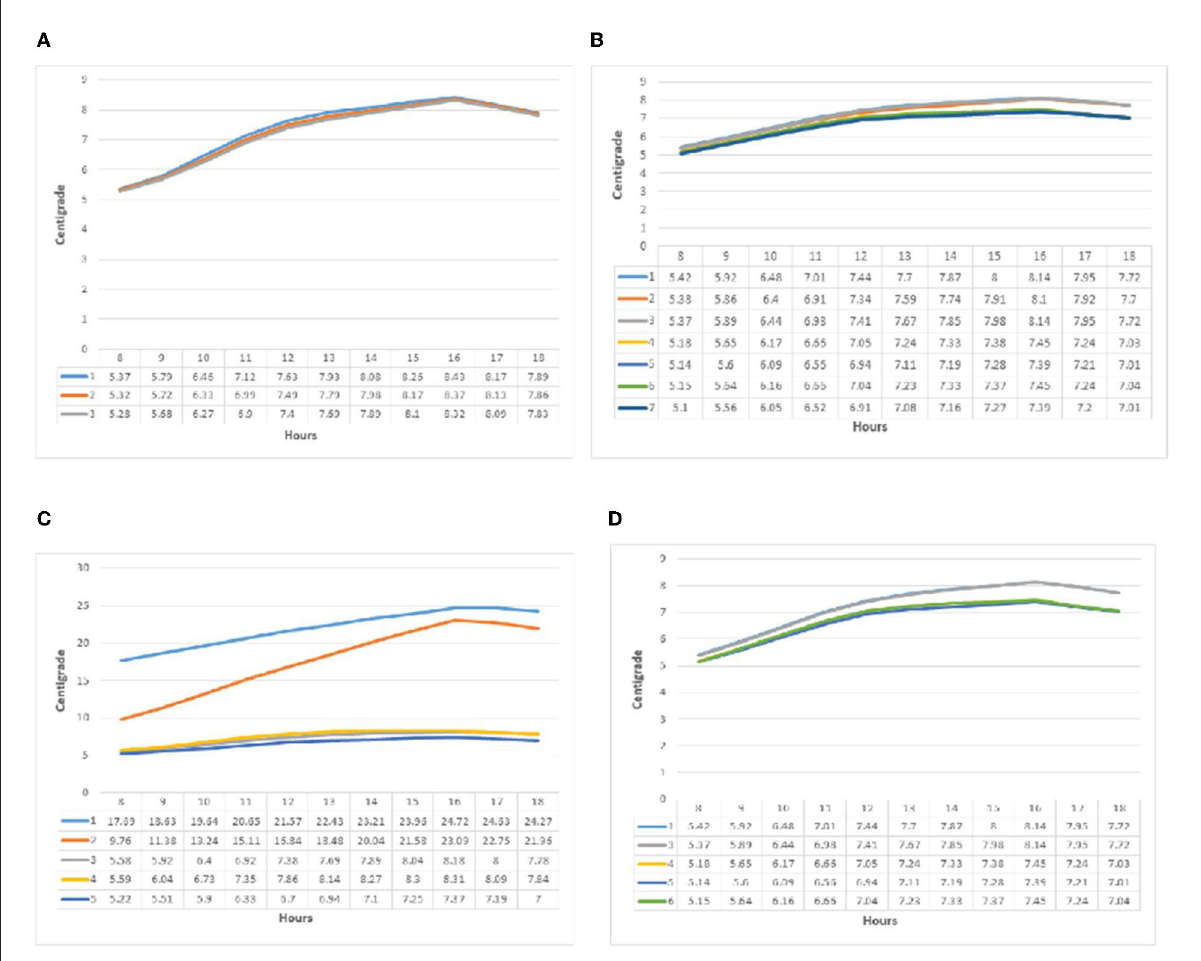
FIGURE6 (A–D) Temperature diagrams from point A in all groups, respectively.